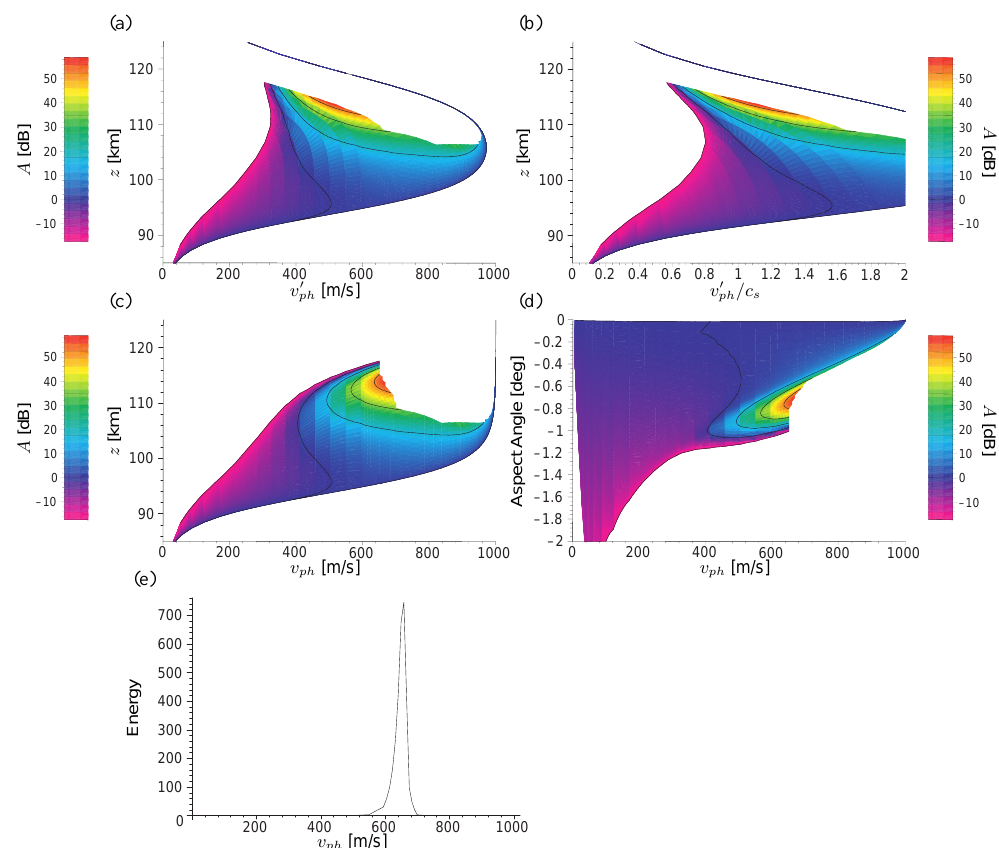
Fig. 6. Frequency and aspect angle dependence of the amplitude (panels a to d) and energy (panel e) for the benchmark run shown in Fig. 5.